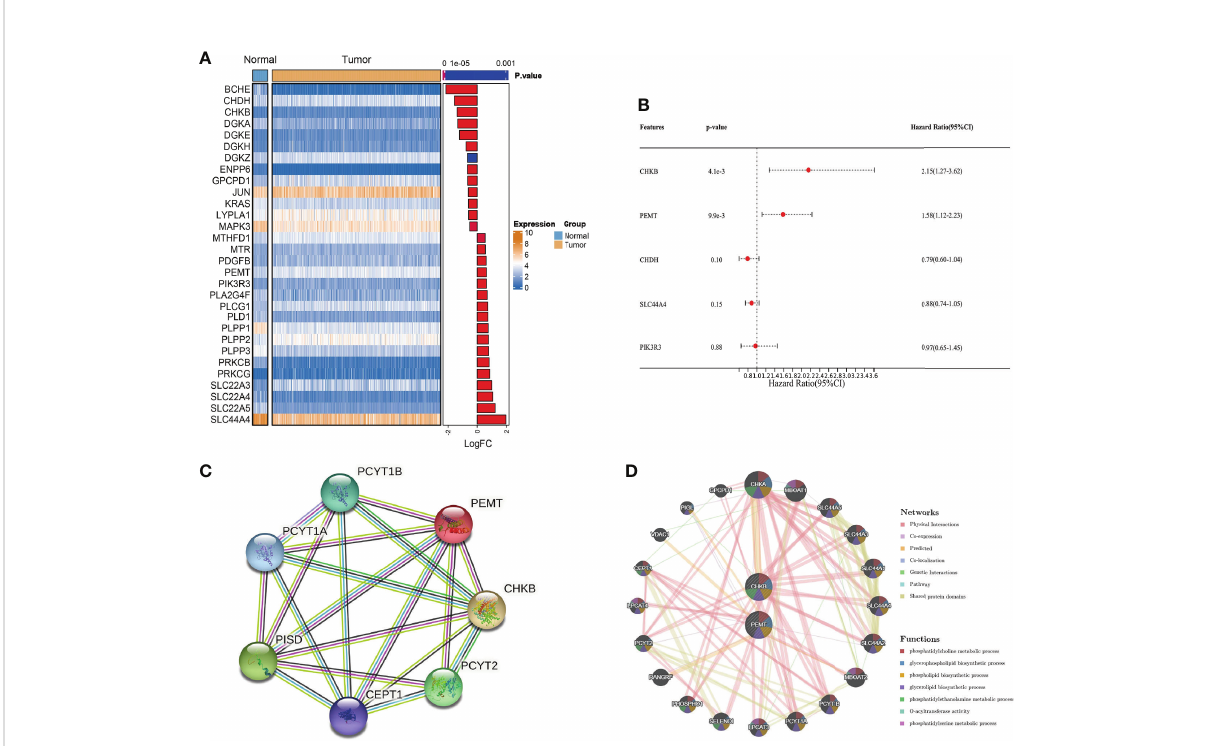
FIGURE 2 Identi fi cation of choline metabolism-related genes. (A) Screening of choline metabolism-related DEGs between COAD tissues and normal tissues. (B) Multivariate Cox regression analysis of choline metabolism-related genes. (C) PPI network of choline metabolism-related genes by the STRING database. (D) Coexpression network of choline metabolism-related genes by the GeneMANIA